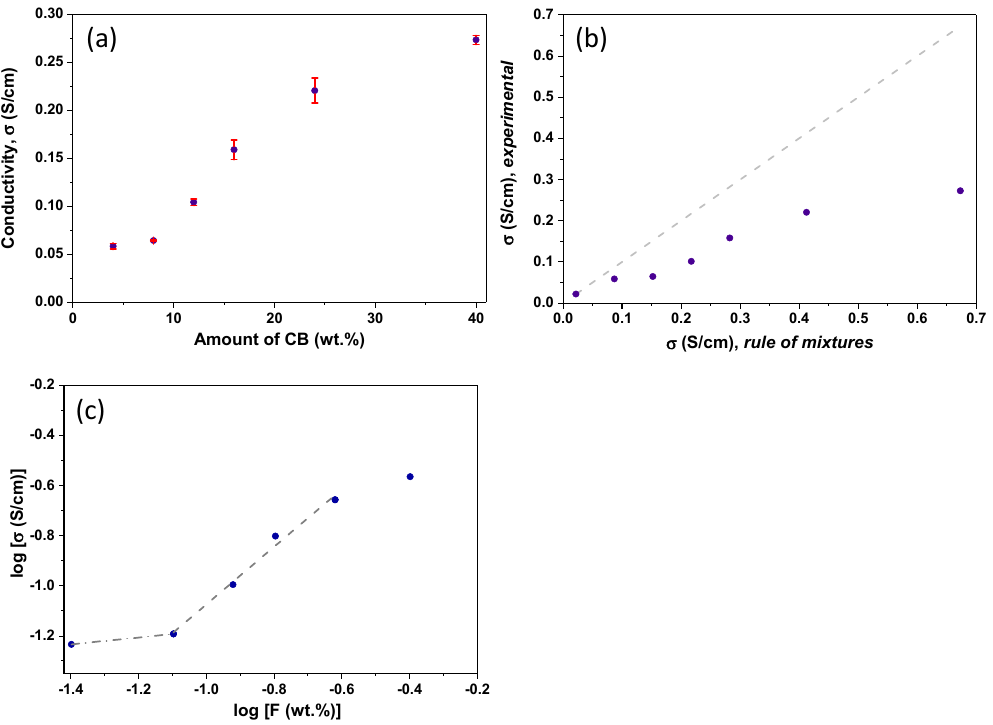
Figure 6. ( a ) Correlation of the electrical conductivity with the amount of carbon black; ( b ) correlation between the experimental conductivity and the values predicted by the general mixing rule; ( c ) log–log plot of the conductivity as a function of the amount of conductive phase following a percolation model.